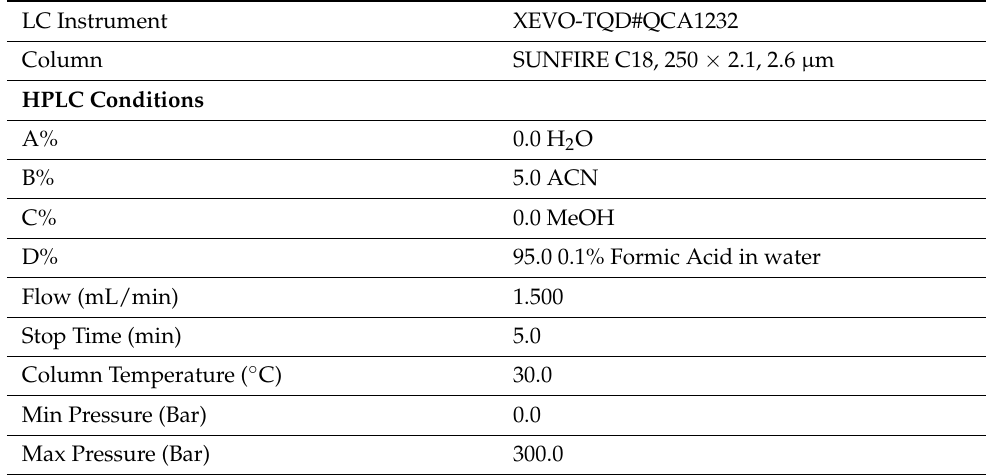
Table 2. Instrument details for LC-MS